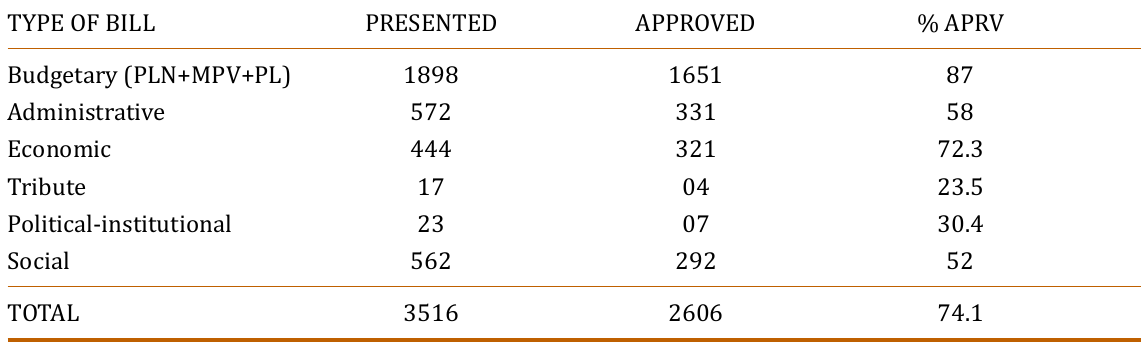
Table 1: Legislative success 15 by type of initiative (Cardoso, Lula and Rousseff) TYPE OF INITIATIVE PRESENTED APPROVED % APRV MPVs PLs TOTAL 1823 1131 62 Source: CEBRAP Legislative Database.